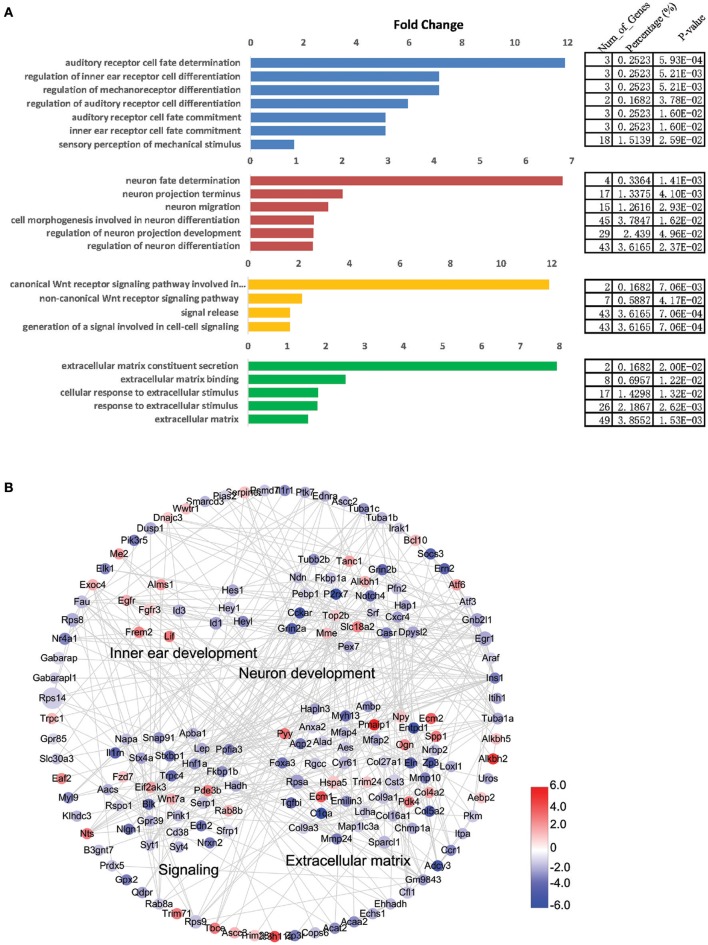
Gene ontology (GO) and network analysis of the differentially expressed genes in NLPs and ULPs. (A) GO analysis of differentially expressed genes in NLPs and ULPs. (B) STRING protein-protein interaction analysis of genes that are upregulated (red) and downregulated (blue) in NLPs. The gray lines indicate protein-protein interactions in the STRING database. The DAVID GO annotation was used to cluster the genes according to biological function.